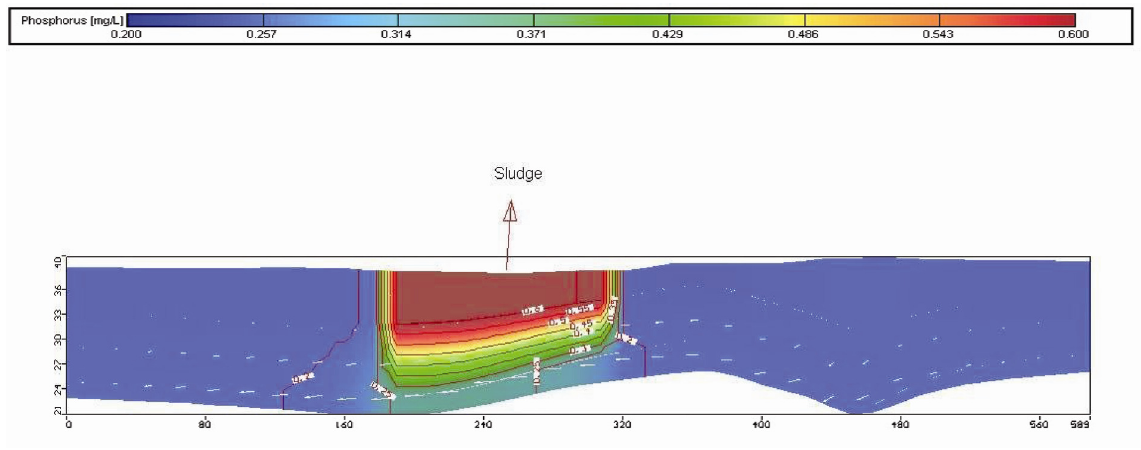
Fig. 7. Cross-sectional view of phosphorus